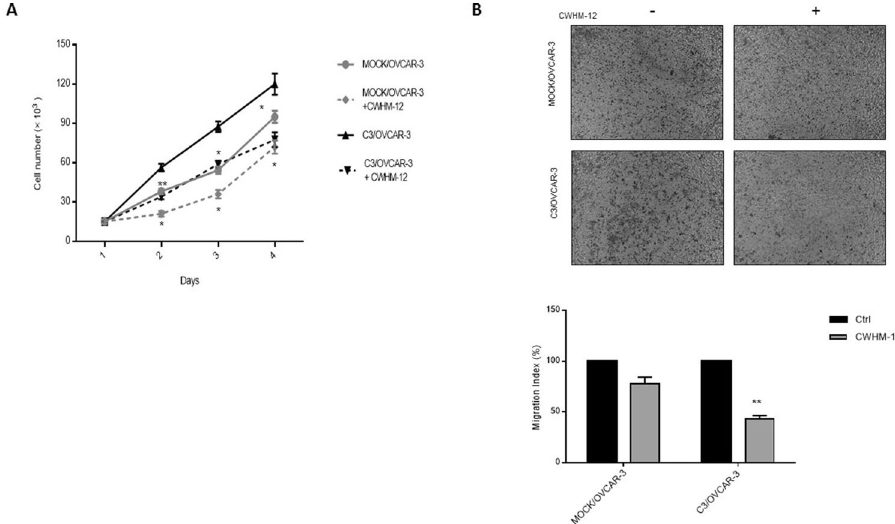
Figure 8. Inhibition of integrin αv decreases proliferation and migration of Wnt5A overexpressed clones. C3/ OVCAR-3 clone or mock cells were treated with 25 μM CWHM- 12 as a specific inhibitor of αv integrin ( A ) Trypan blue exclusion ( B ) Transwell cell migration assay (scale bar: 100 μM). The results are expressed as mean + SD relative to untreated cells from three independent experiments each performed in triplicate. * P < .05; ** P <